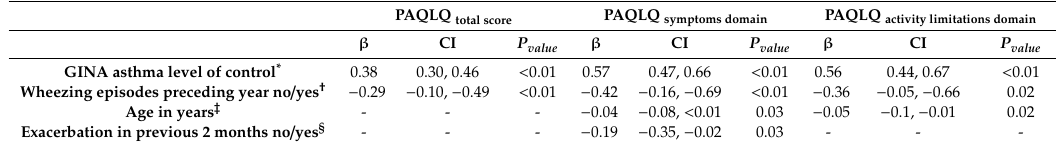
GINA = Global Initiative for Asthma, PAQLQ = Pediatric Asthma Control Quality of Life Questionnaire, β =